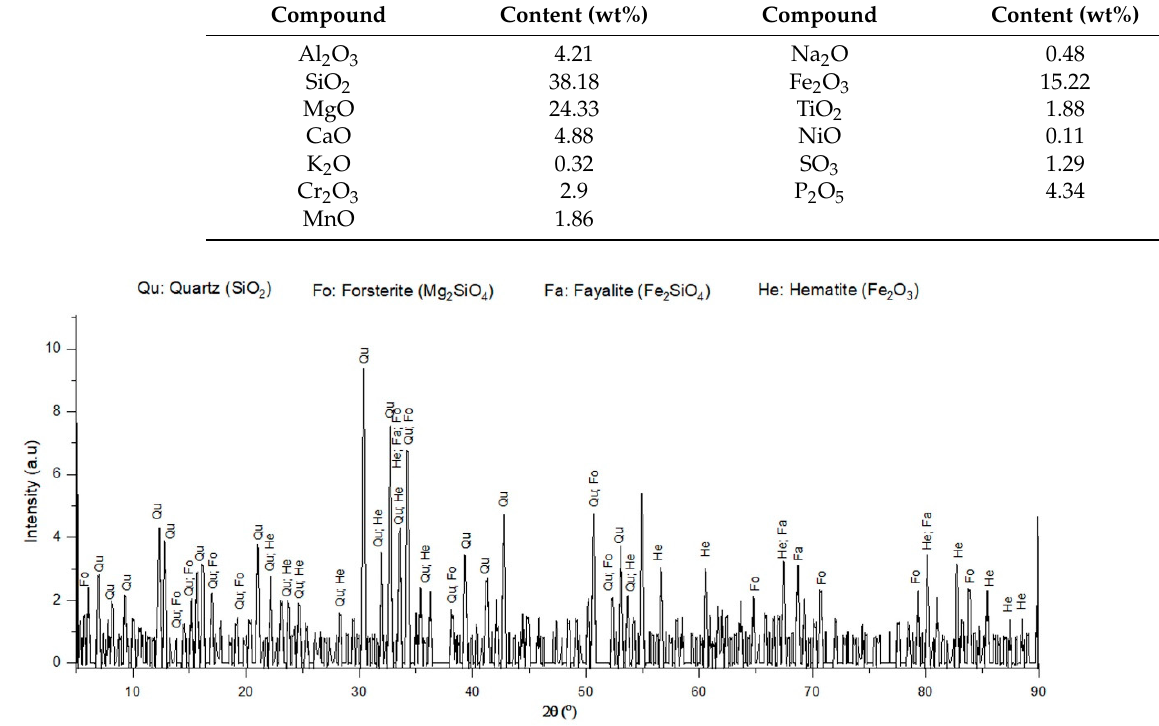
Figure 12. XRD patterns of ferronickel slag.